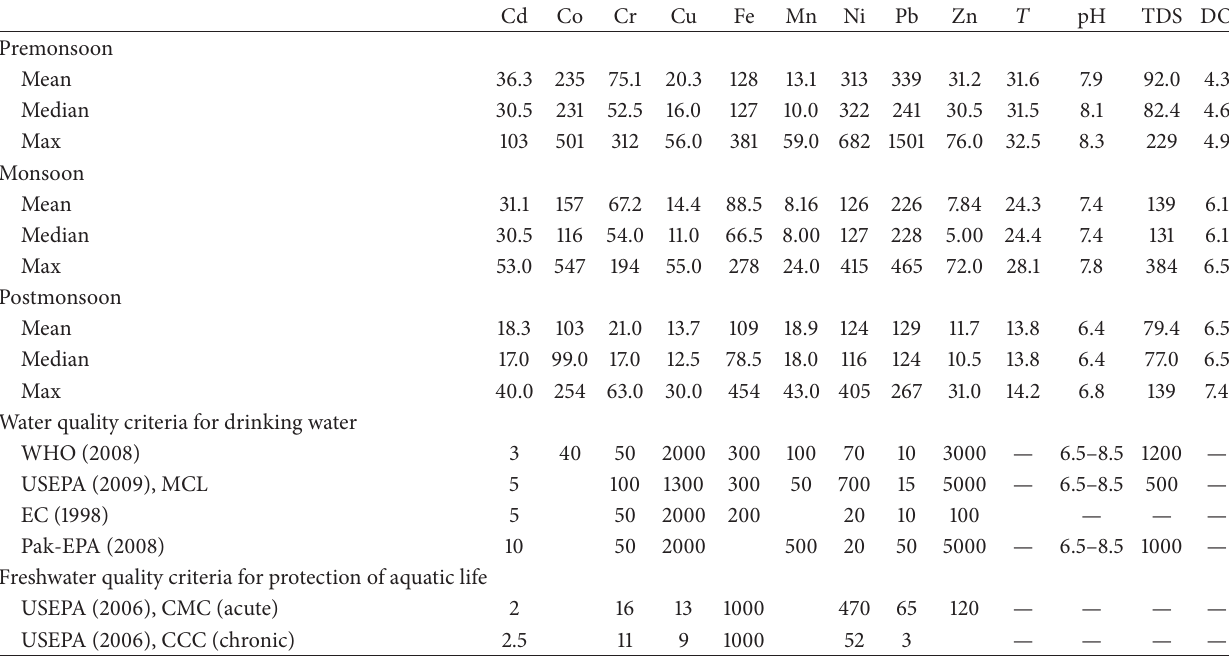
Table 2: Descriptive statistics for trace metals ( 𝜇 g/L) and water quality parameters in comparison with national/international guidelines.